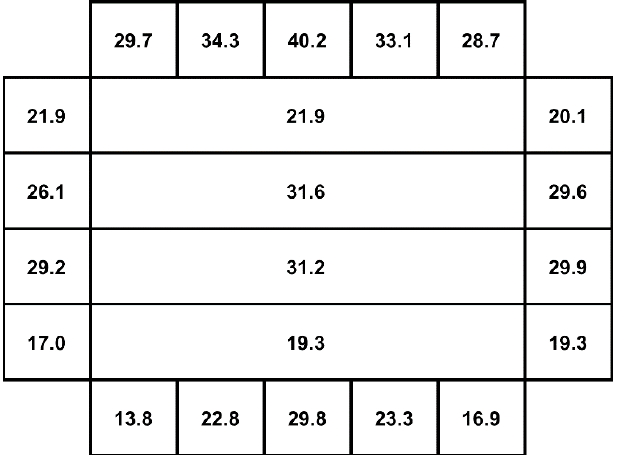
Figure 23. Count rates (cps) of the SciFi n.12 in the twenty-two positions on top and around the AmBe source box sketched in Figure 22. AmBe source box sketched in Figure